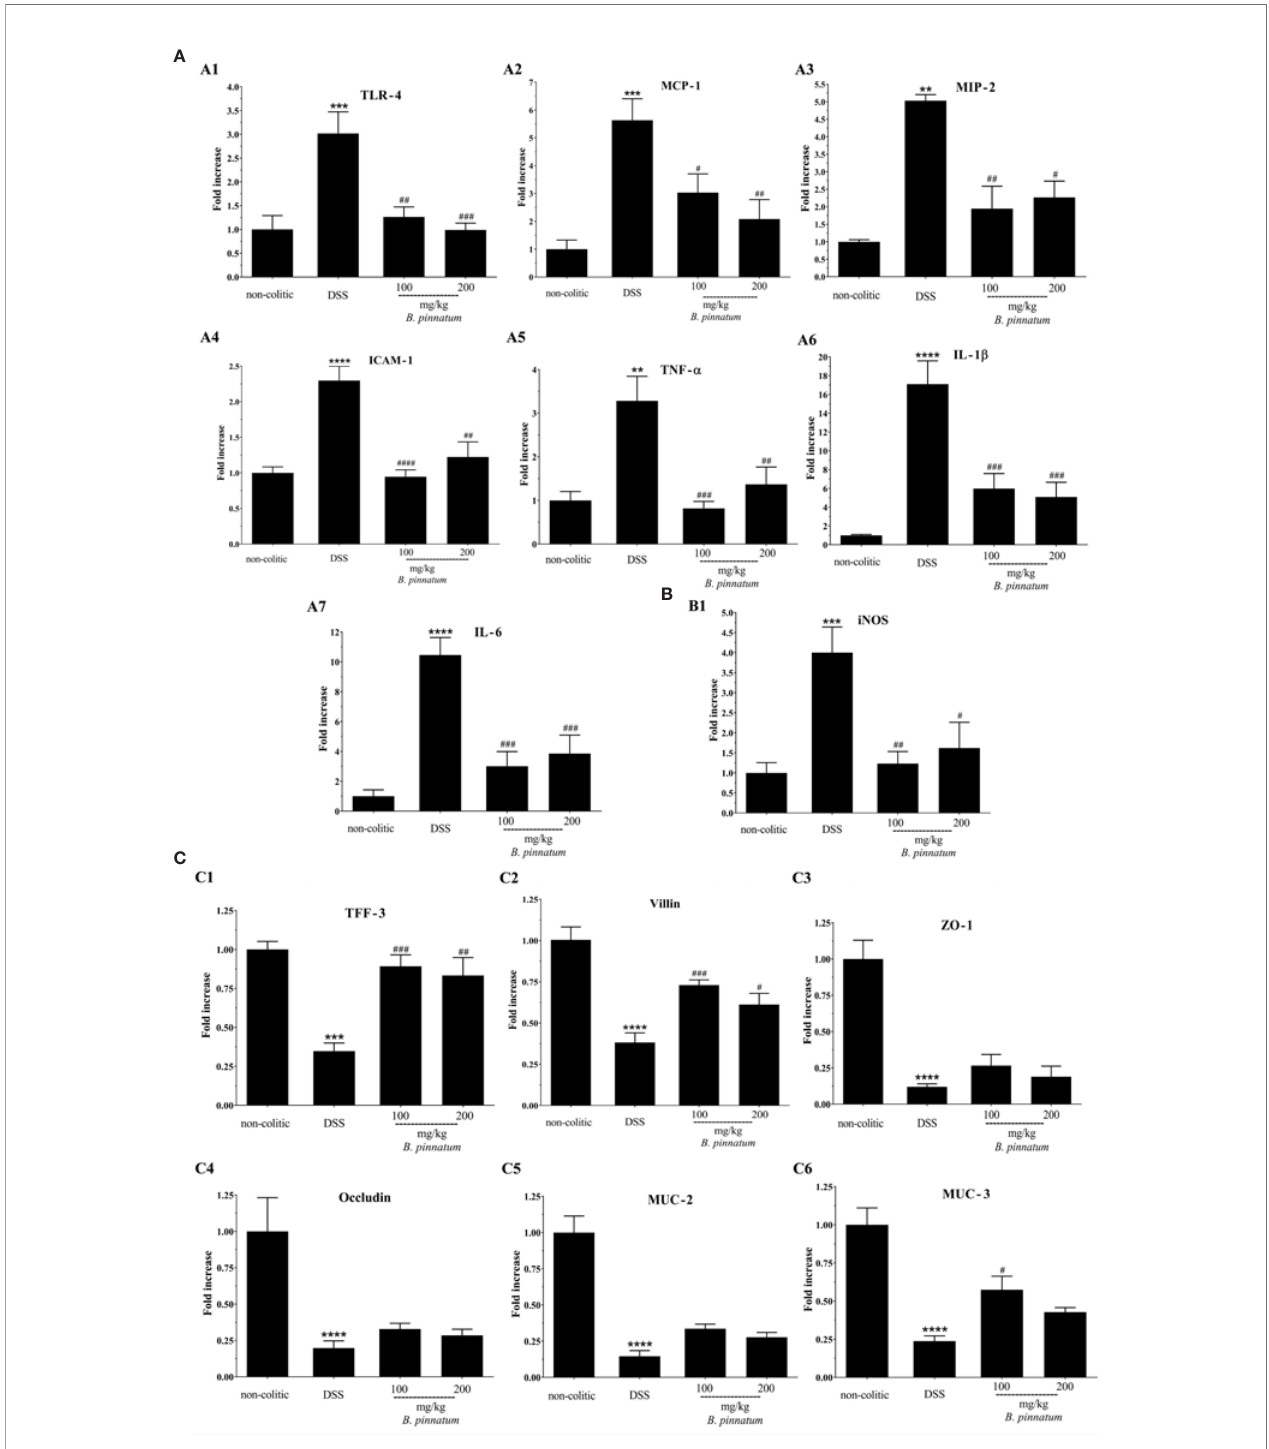
FIGURE 7 | Effect of hydroethanolic extract from B. pinnatum leaf (HEBP) on colonic gene expression of different mediators in dextran sulfate sodium (DSS) – induced colitis analyzed by reverse transcription − quantitative polymerase chain reaction (RT-qPCR). In fl ammation markers (A) : TLR-4 ( A1 ), MCP-1 ( A2 ), MIP-2 ( A3 ), ICAM-1 ( A4 ), TNF- a ( A5 ), IL-1 b ( A6 ), IL-6 ( A7 ), oxidative marker (B) : iNOS ( B1 ) and markers involved in epithelial barrier integrity (C) : TFF-3 ( C1 ), villin ( C2 ), ZO-1 ( C3 ), occludin ( C4 ), MUC-2 ( C5 ), and MUC-3 ( C6 ). Data (n = 8) are presented as mean ± standard error from the mean. ** p < 0.01, *** p < 0.001, **** p < 0.0001 compared with non-colitic group; # p < 0.05, ## p < 0.01, ### p < 0.001, #### p < 0.0001 compared with DSS